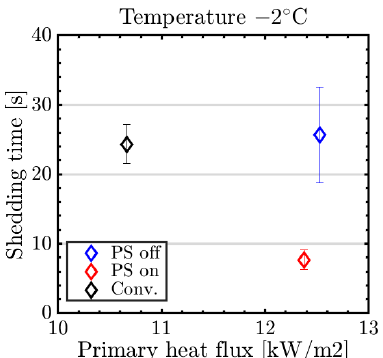
Figure 13. Comparison of shedding times between conventional (Conv.) and parting strip (PS) IPS, with activated (PS on) and deactivated parting strip (PS off).